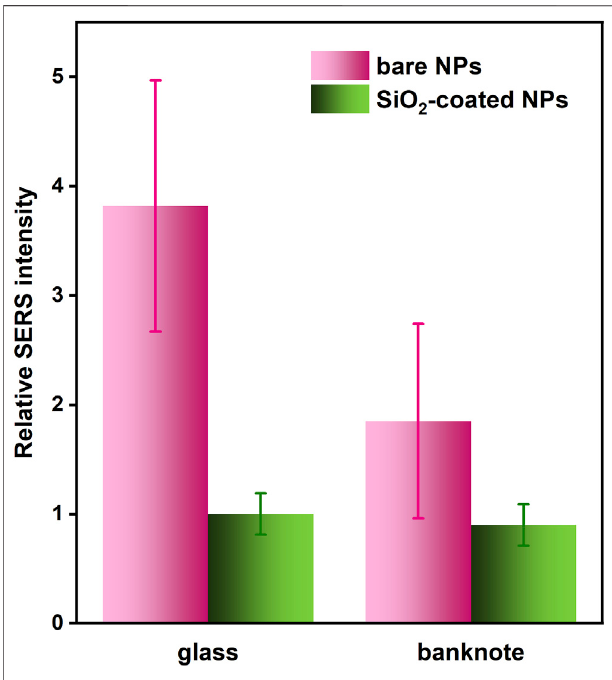
FIGURE 11 | Comparison of the average intensity of MES SERS band around 790 cm − 1 (with error bars showing the RSD values) for bare and SiO 2 - coated Fe 3 O 4 /Ag@MES NPs deposited. Typically 20 – 25 spots localized across 140 μ m × 120 μ m rectangular area were analysed in each case. RelativeintensitycorrespondstoSERSsignalwithrespecttothisobservedfor the silica coated NPs on glass (normalized to unity). The values of RSD were also recalculated according to this